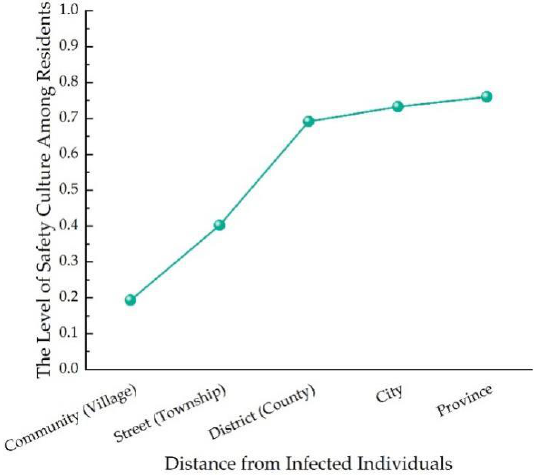
Figure 9. Safety culture of residents in communities with different distances from COVID-19 cases.